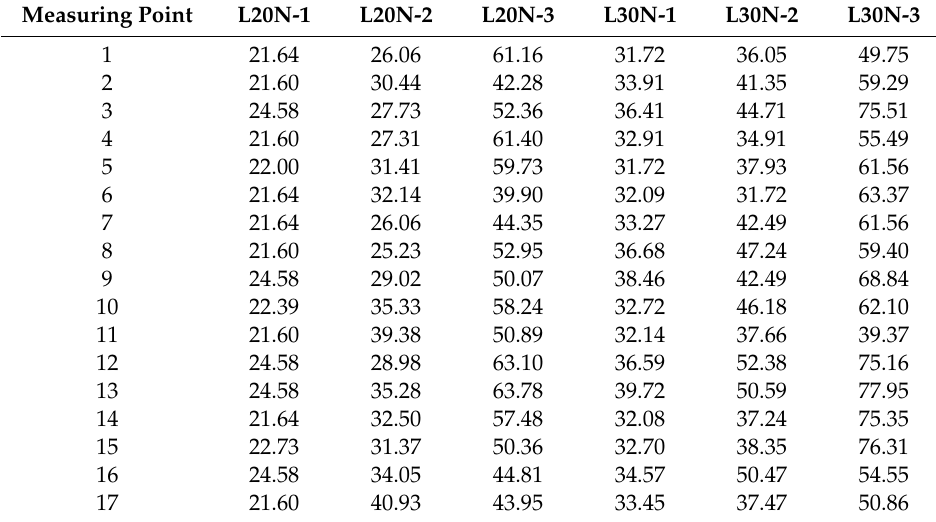
Table A2. The scale coe ffi cient C.